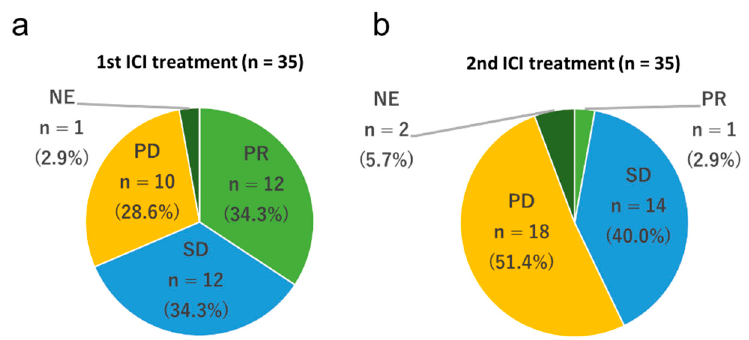
Figure 1. Frequency of the best overall response to immune checkpoint inhibitors (ICIs). ( a ) Frequency of the best overall response to first ICI treatment. ( b ) Frequency of the best overall response to ICI rechallenge treatment. PD, progressive disease; PR, partial response; SD, stable disease; NE, not evaluated.